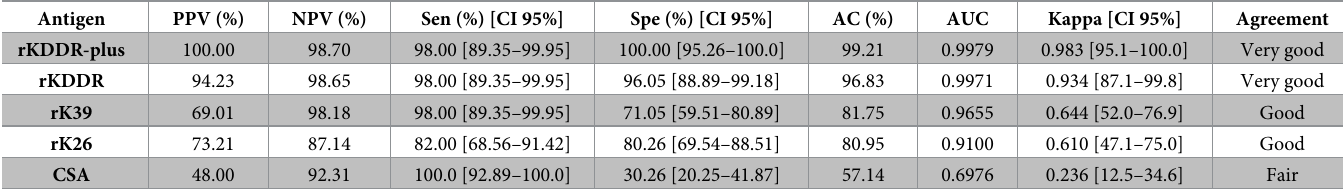
PPV: positive predictive value; NPV: negative predictive value; Sen: sensitivity; Spe: specificity; AC: accuracy; AUC: area under curve; CI: confidence interval; CSA: crude soluble antigen. Reference test: